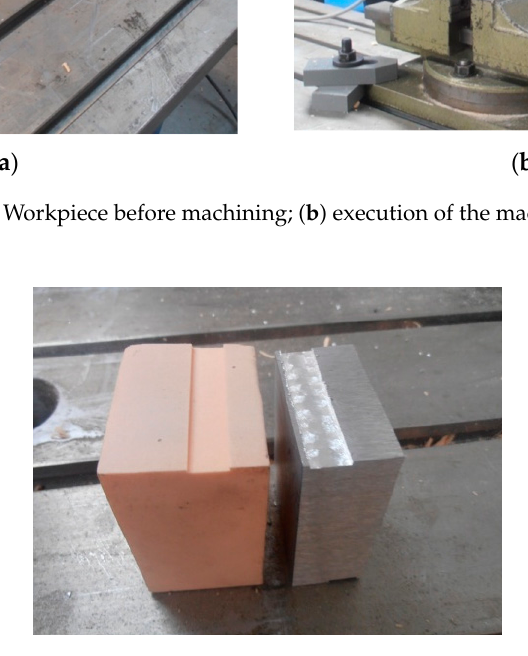
Figure 5. ( a ) Workpiece before machining; ( b ) execution of the machining tests.